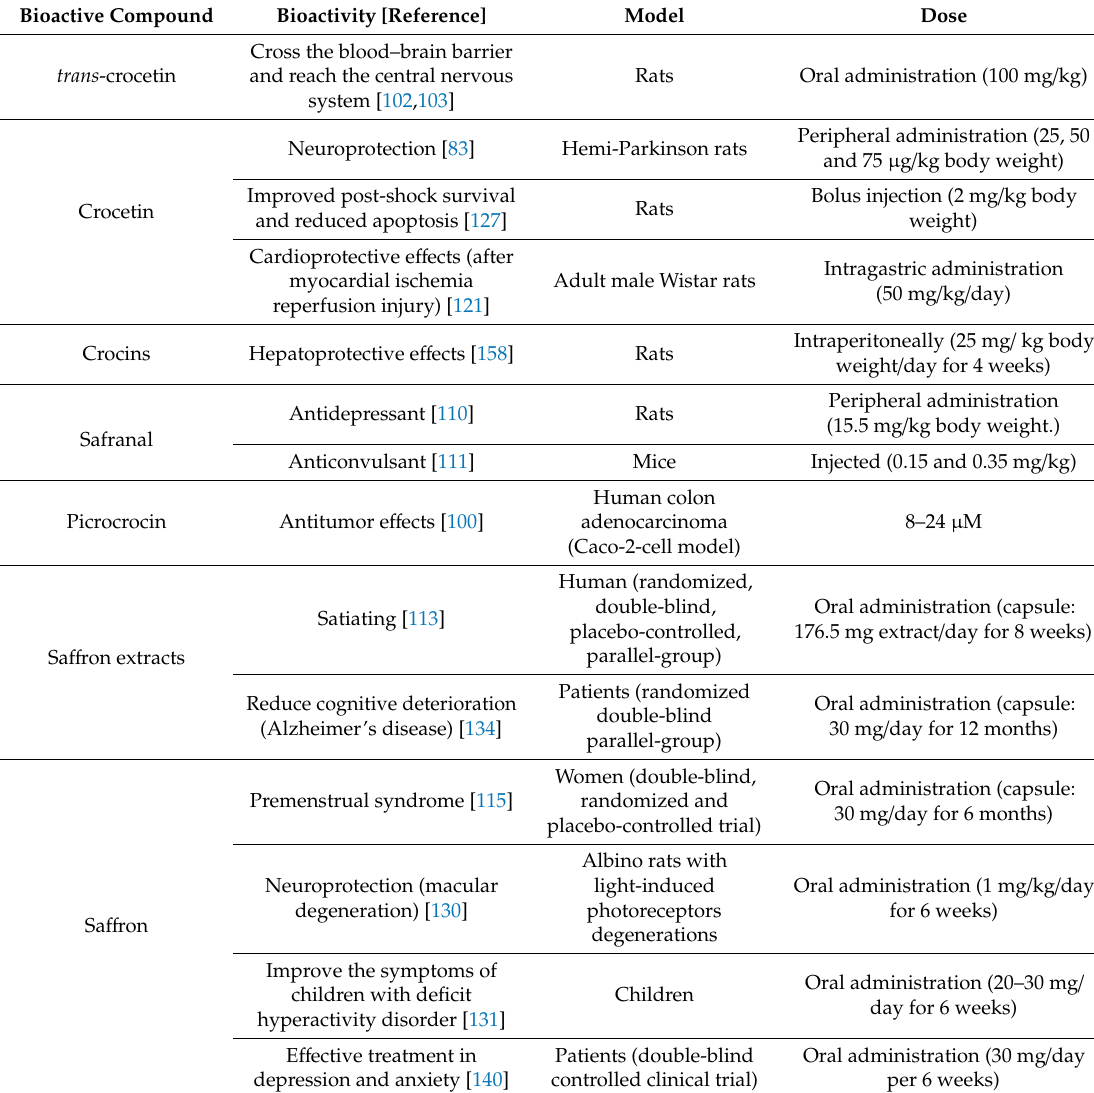
Table 2. Summary of the main bioactivity of sa ff ron and its bioactive